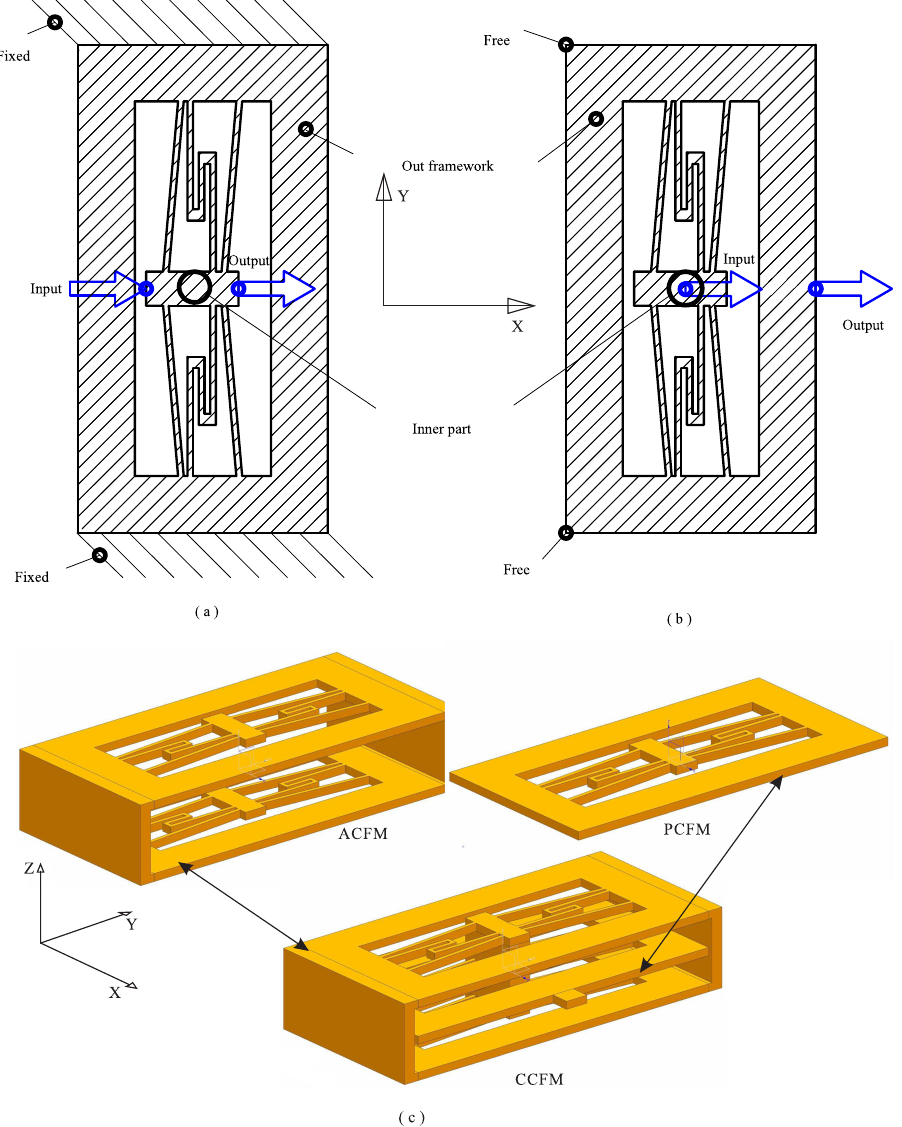
Figure 1. Schematic of the proposed CCFM. ( a ) ACFM in top and bottom layers; ( b ) PCFM in middle layer; ( c ) Construction of the